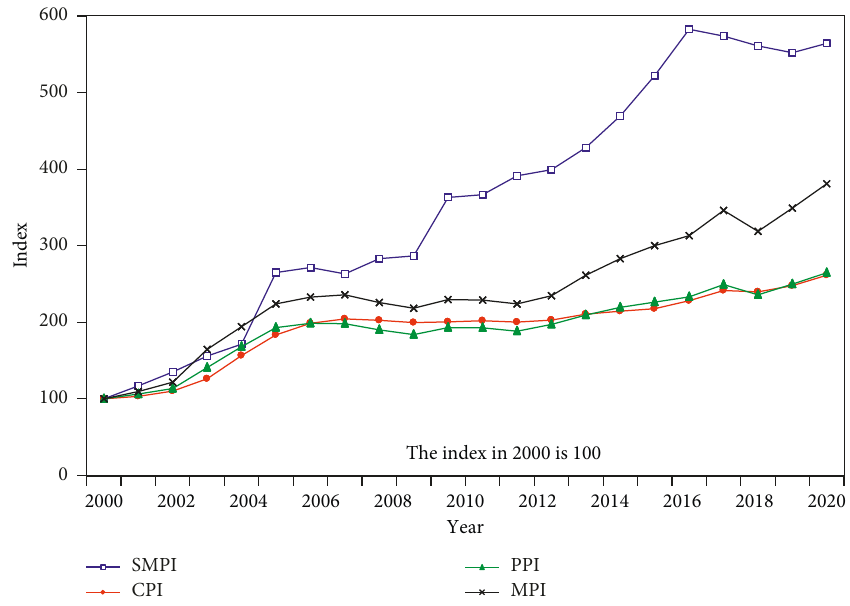
Figure 2: Trend of SMPI, CPI, PPI, and